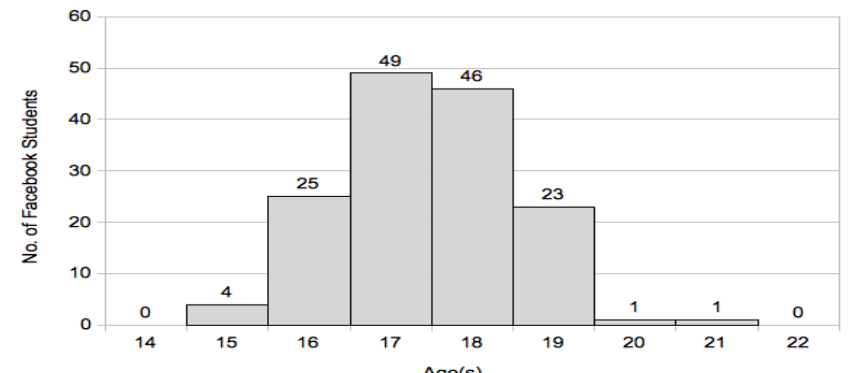
Figure 3 . Age distribution of student Facebook users.